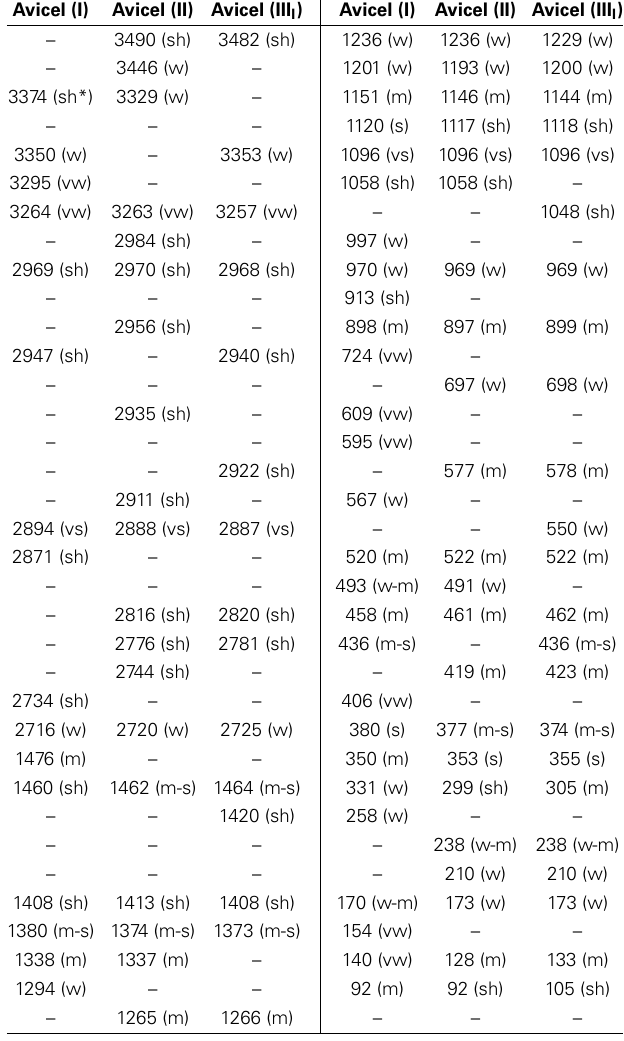
very weak; sh, shoulder.